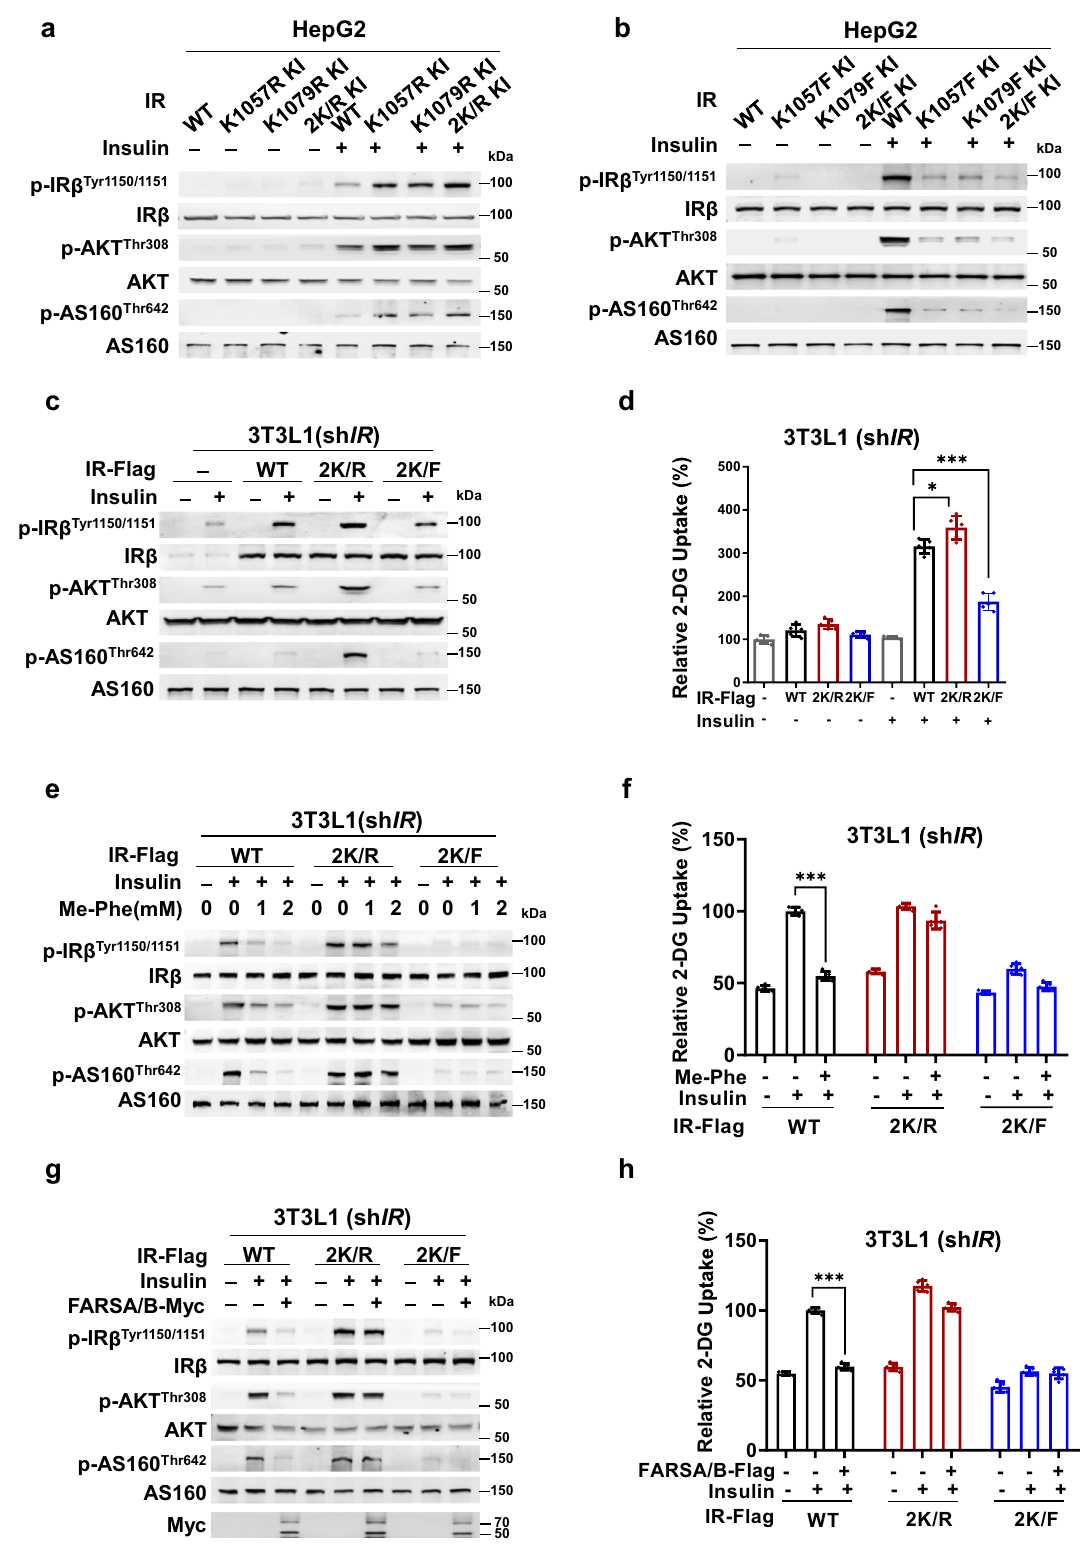
Antibodies against PAH (ab178430, 1:3000), IR β (ab69508, 1:1000), GLUT4 (ab654, 1:3000) was purchased from Abcam (Cambridge, UK) . The antibodies against FARSA (18121-1-AP, 1:1000), SIRT1 mouse (60303-1-lg, 1:1000), FARS2 (16436-1-AP, 1:1000) was purchased from Proteintech (Rosemont, USA) . The antibody against Actin(#A00702, 1:5000), anti-rabbit secondary antibody and anti-mouse secondary